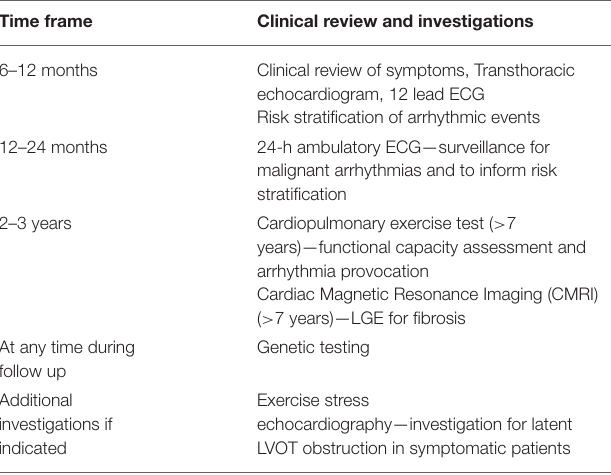
TABLE 2 | Proposed follow up and investigations for childhood Hypertrophic